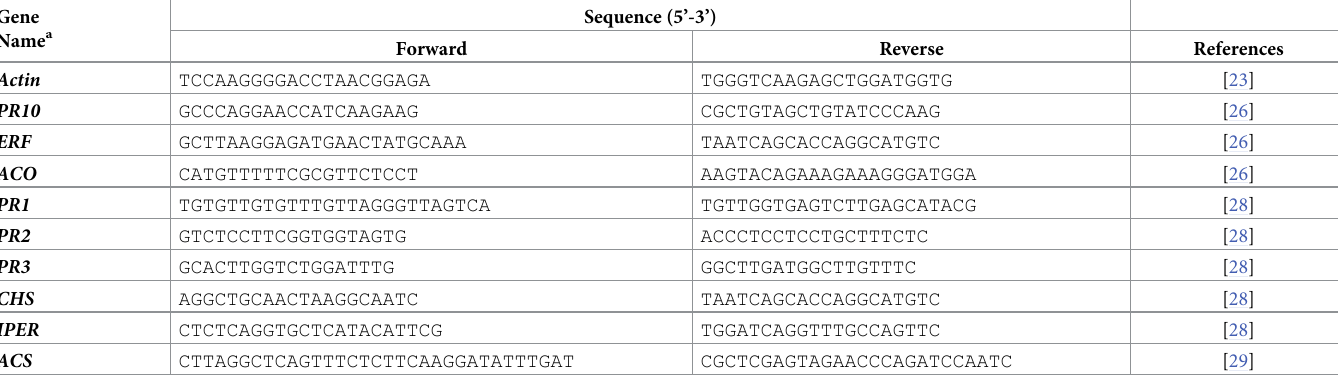
a PR1 = PR1a precursor antimicrobial protein, PR2 = β -1,3-Endoglucanase, PR3 = Chitinase class I, PR10 = Intercellular pathogenesis-related, CHS = Chalcone synthase, IPER = Basic peroxidase, ERF = Ethylene response factor 1, ACO = 1-aminocyclopropane-1-carboxylic acid oxidase, ACS = 1-aminocyclopropane-1-carboxylic acid synthase, Actin = Soybean β